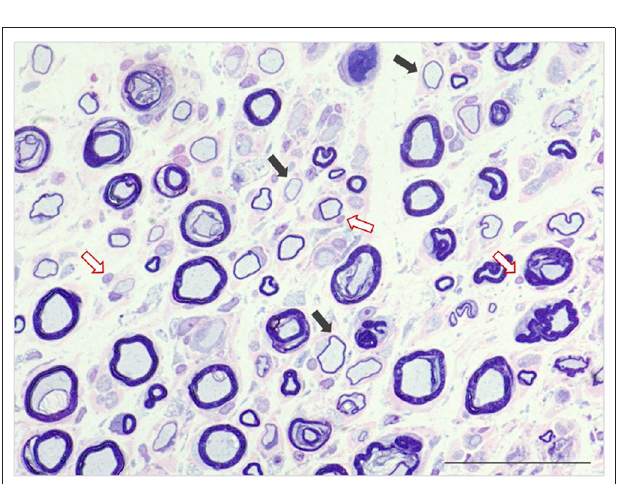
FIGURE 2 | Semithin section of peroneal nerve featuring reduced density of nerve fibers and mild expansion of the endoneurial fibrocollagenous tissue. There are numerous fibers with marked reduction of myelin sheath thickness (demyelination—black arrows) accompanied by multiple fiber adhesive mononuclear cell infiltrates and overall increased endoneurial cellularity (red arrows). Stained with Azurblue Safranin, scale bar 500 µ